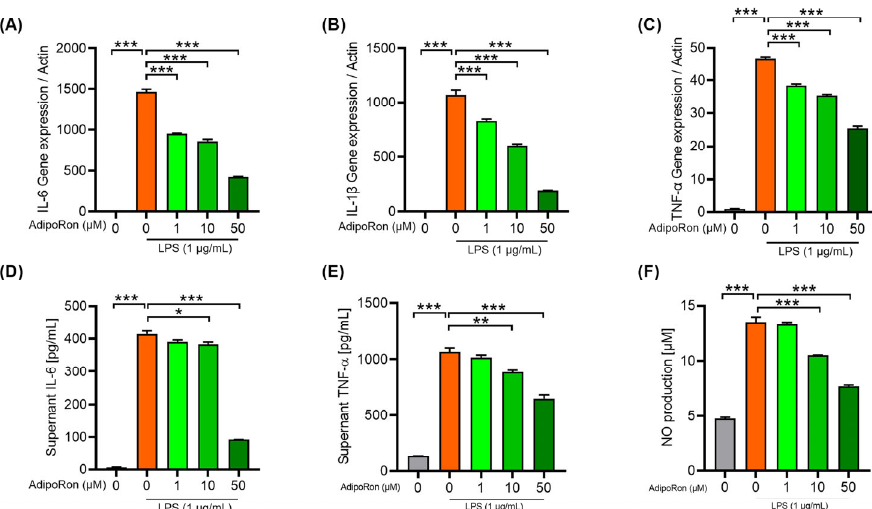
Figure 7. Anti-neuroinflammation effect of AdipoRon on BV2 cells. mRNA expression of the IL-6 ( A ), IL-1 β ( B ) and TNF- α ( C ) were measured relative to Actin by quantitative real-time polymerase chain reaction. BV2 cells were preincubated with AdipoRon (0–50 µ M) or vehicle (dimethyl sulfoxide) for 1 h before stimulation with lipopolysaccharide (1 µ g/mL) for 4 h. Concentration of IL-6 ( D ) and TNF- α ( E ) in culture supernatants was quantified by ELISA (n = 3). BV2 cells were preincubated with AdipoRon (0–50 µ M) or vehicle for 1 h before stimulation with lipopolysaccharide (1 µ g/mL) for 6 h. Concentration of NO ( F ) in culture supernatants was quantified by a Nitric Oxide Assay Kit (n = 3). BV2 cells were preincubated with AdipoRon (0–50 µ M) or vehicle for 1 h before stimulation with lipopolysaccharide (1 µ g/mL) for 24 h. Results are presented as the mean ± SEM. Differences between experimental groups were analyzed statistically by performing one-way ANOVA followed by Bonferroni’s multiple comparison tests. IL-6: interleukin 6, IL-1 β : interleukin 1 β ; TNF- α : tumor necrosis factor α . * p < 0.05, ** p < 0.01, and *** p < 0.001.